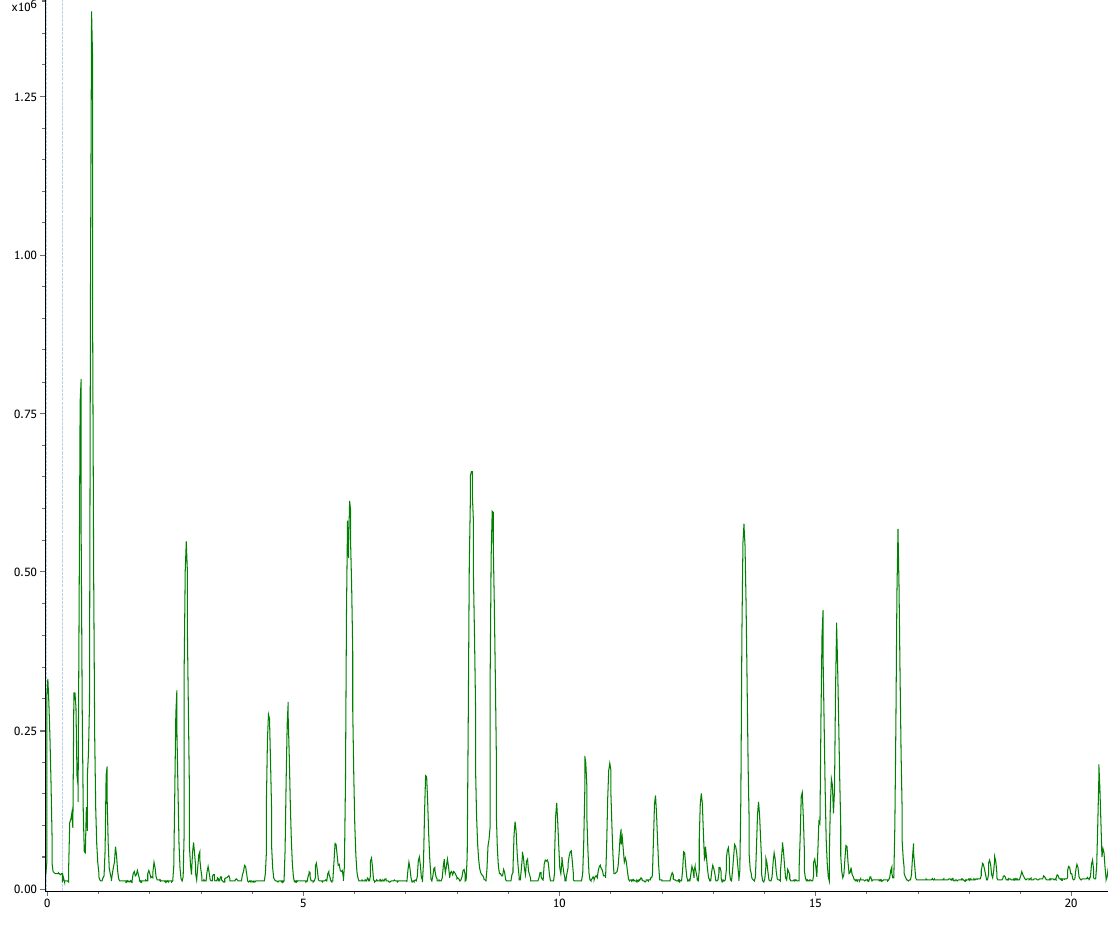
Figure A6. Ilex aquifolium ‘Argentea Marginata’, basic peak chromatogram, negative mode.